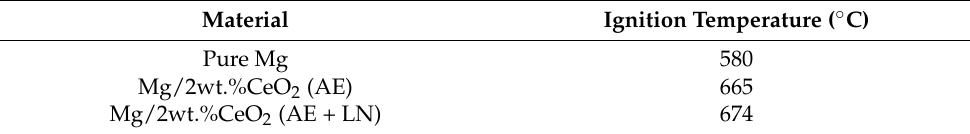
Table 3. Results of ignition temperature measurements.